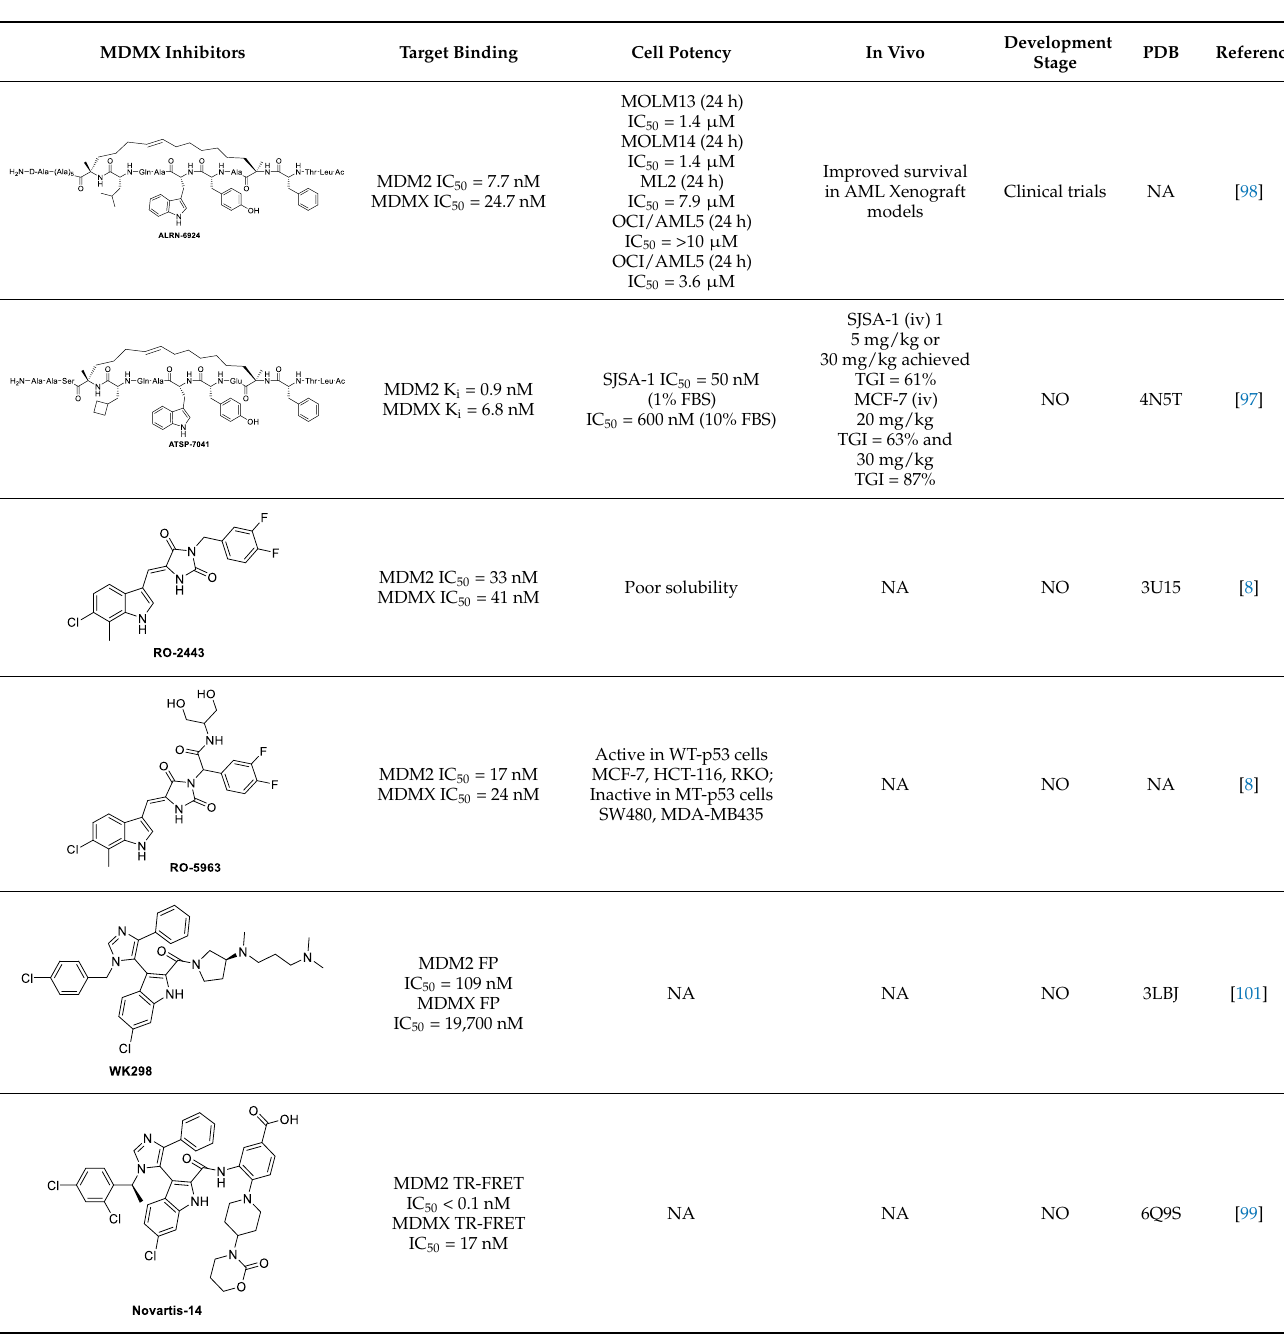
Table 3. MDMX inhibitors.